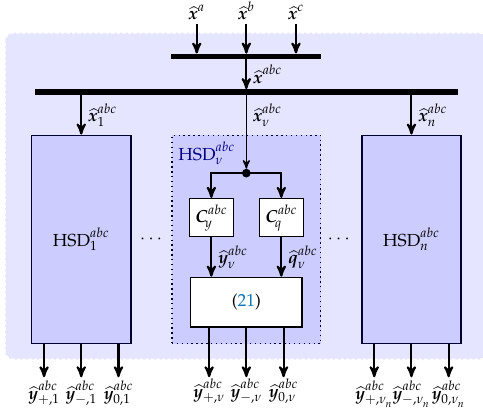
Figure 4. Block diagram of the HSD abc